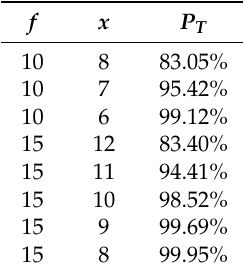
Table 3. Some practical variables and the corresponding results.